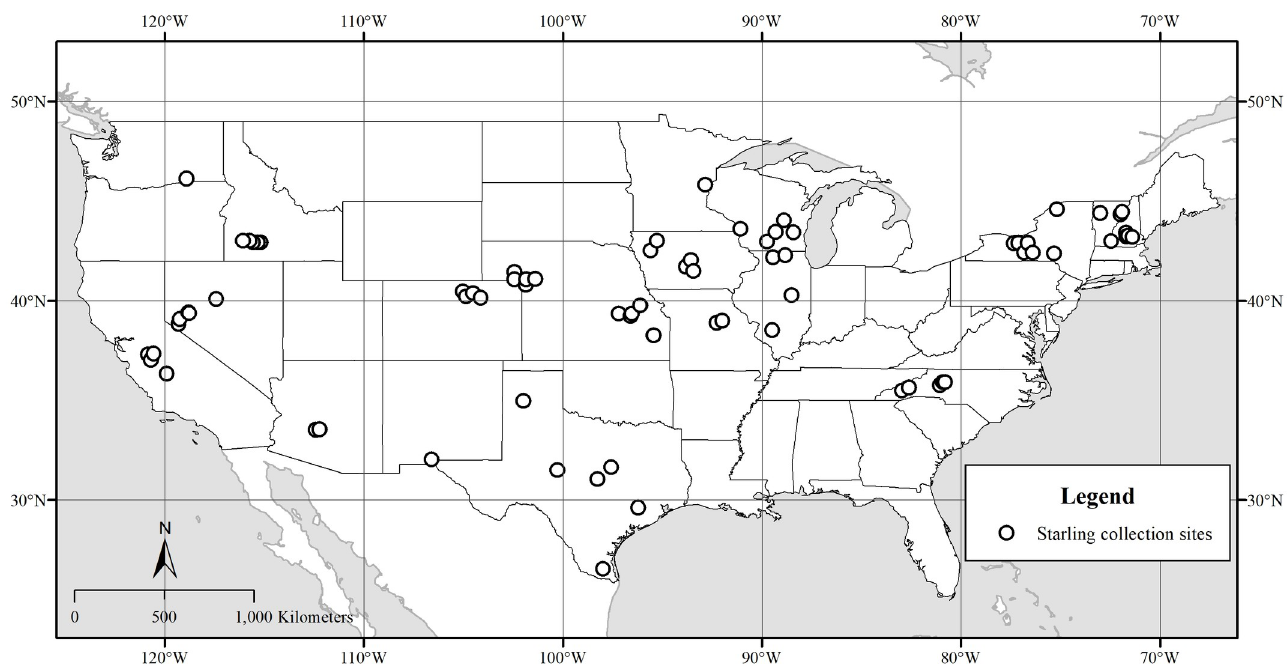
Fig 1. Geographic range of feather-sample collection sites used to develop multi-isotopic depictions of molt origin for European starlings collected at U.S. dairies and feedlots.